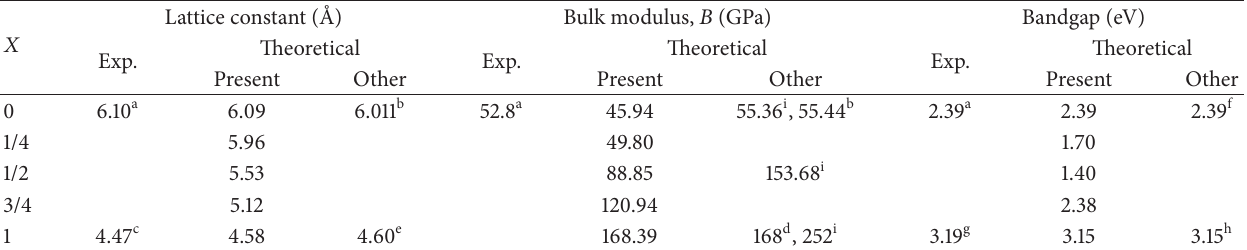
Table 1: Calculated lattice constants, bulk moduli, and bandgaps compared with experimental and other theoretical results. Lattice constant (˚A) Bulk modulus, 𝐵 (GPa) Bandgap (eV) 𝑋 Theoretical Theoretical Theoretical Exp. Exp. Exp. Present Other Present Other Present Other